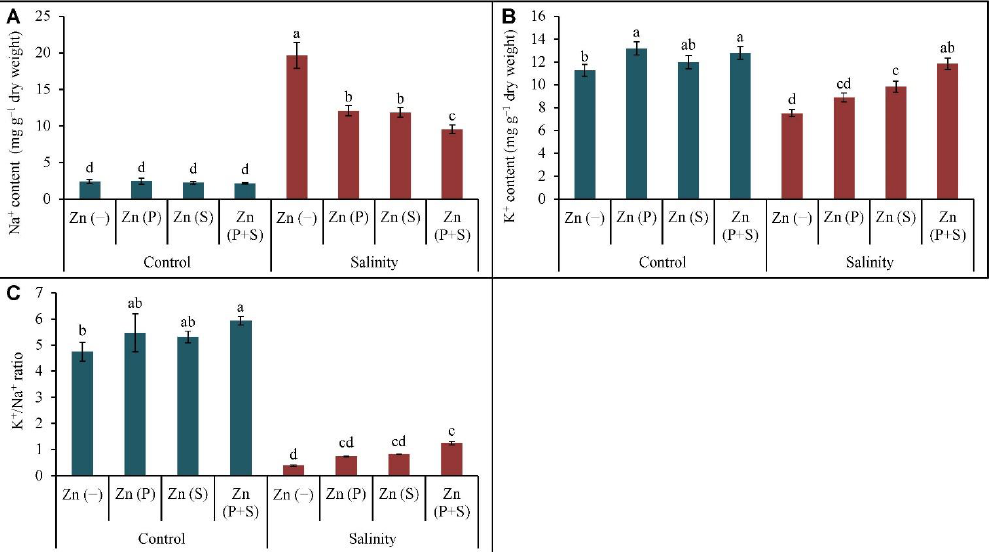
Figure 8. Content of Na + ( A ) and K + ( B ) and K + /Na + ( C ) of soybean plants induced by Zn supple- mentation. Twenty five-day-old plants were subjected to salt (150 mM NaCl) and supplemented with Zn (1 mM ZnSO 4 ·7H 2 O). P and S indicate seed priming and foliar application with Zn, respec- tively. Control treatments were grown with water. Mean (± SD) was calculated from three replicates for each treatment. Different letters of bars indicate significant differences at p ≤ 0.05 applying Tukey’s HSD test.